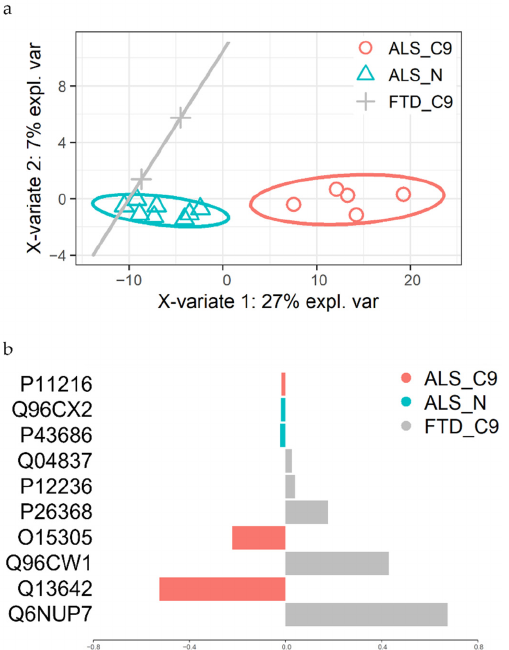
Figure 7. sPLS-DA analysis . Supervised multivariate analysis was performed considering all quantified proteins in fibro- blasts from patients included in the three groups. ( a ) Scatter plot displaying the distribution of all patients. Pink: ALS_C9; n = 5. Light blue: ALS_N; n = 8. Grey: FTD_C9; n = 2. ( b ) Proteins mainly contributing to the separation along the PC2, thus discriminating FTD from all ALS patients.